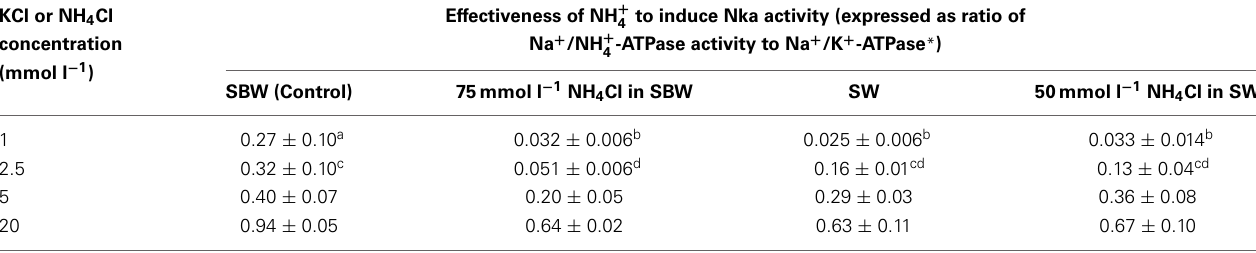
KCl or NH 4 Cl Effectiveness of NH +